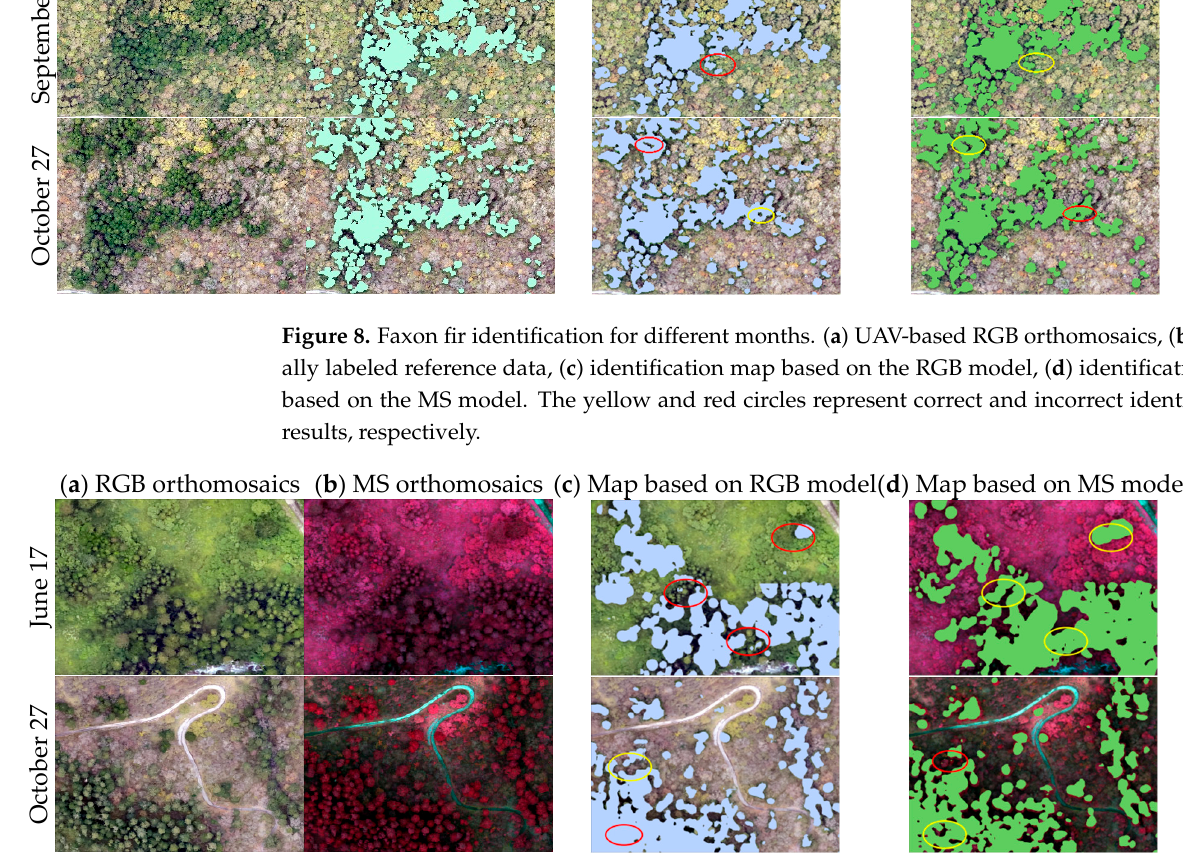
Figure 9. Faxon fi r identi fi cation of trained CNN on the adjacent sample sites for di ff erent months. ( a ) UAV-based RGB orthomosaics, ( b ) UAV-based MS orthomosaics, ( c ) identi fi cation map based on the RGB model, ( d ) identi fi cation map based on the MS model. The yellow and red circles represent correct and incorrect identi fi cation results, respectively.